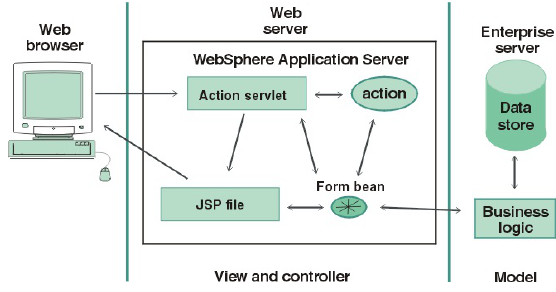
Fig. 2 Struts frame structure. JSP, Java Server Pages.